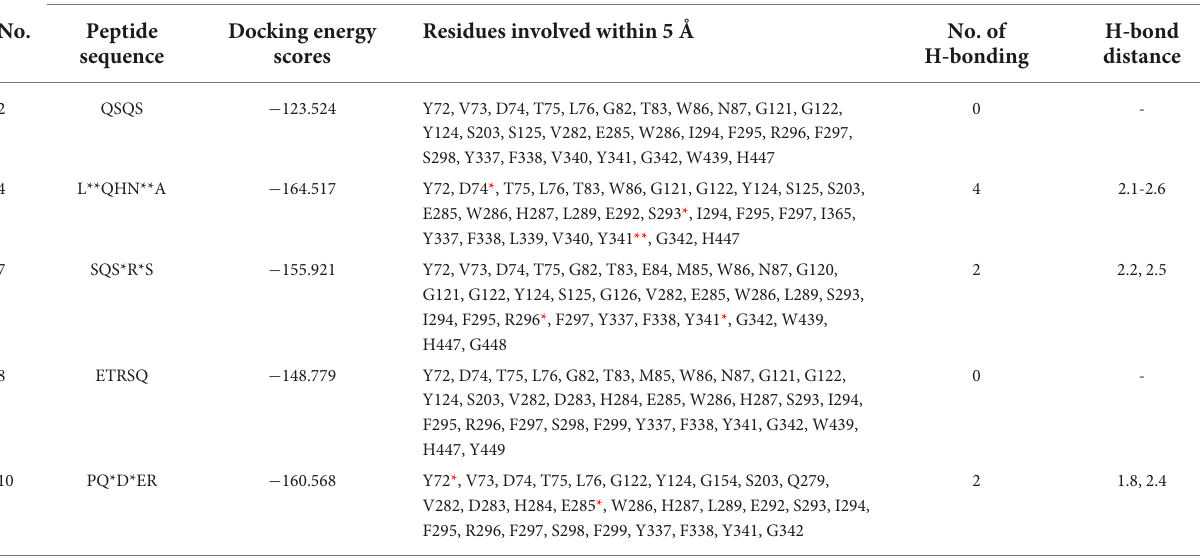
TABLE 4 Relative binding affinity of peptide to acetylcholinesterase, residues involved within 5Å to the binding site, and hydrogen-bonding